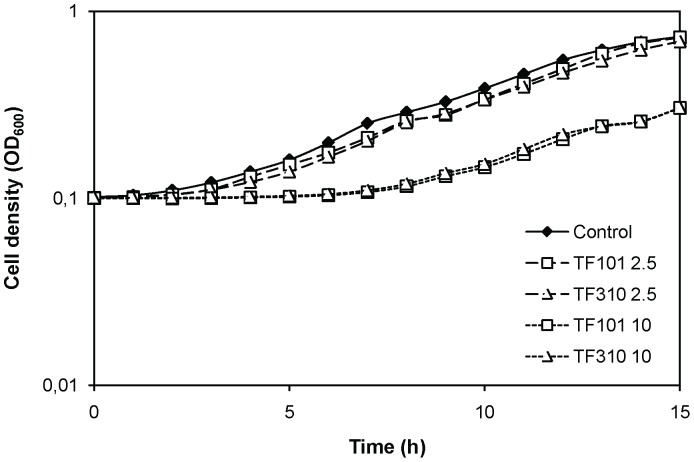
Growth of Vibrio harveyi BB120 in Luria-Bertani medium containing 35 g l−1 of synthetic sea salt, with and without the thiophenones at 2.5 and 10 µM (average of 4 replicates).Error bars are too small to be visible.